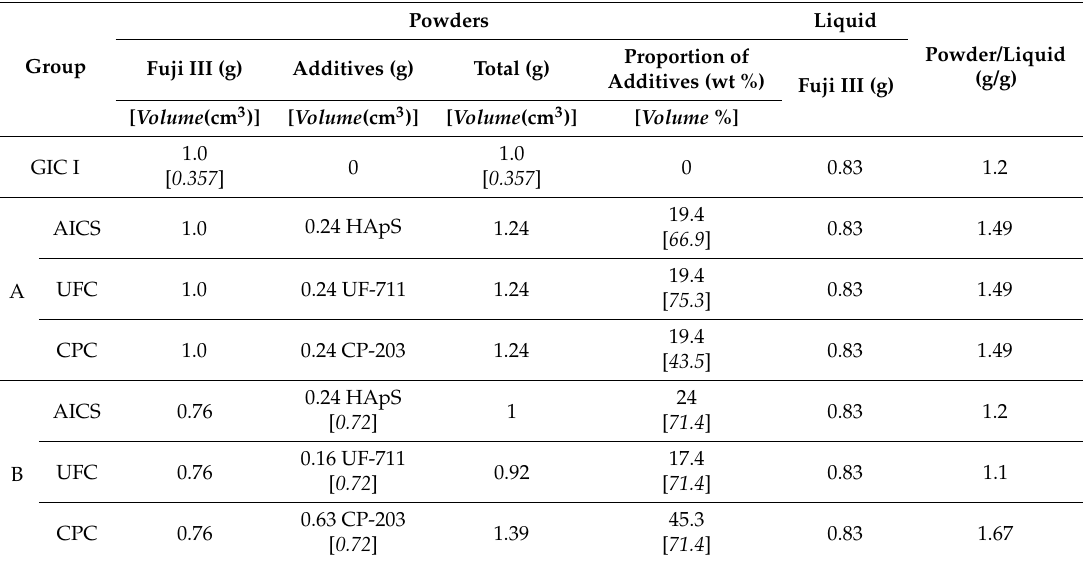
Table 1. The compositions of specimens used in Experiment